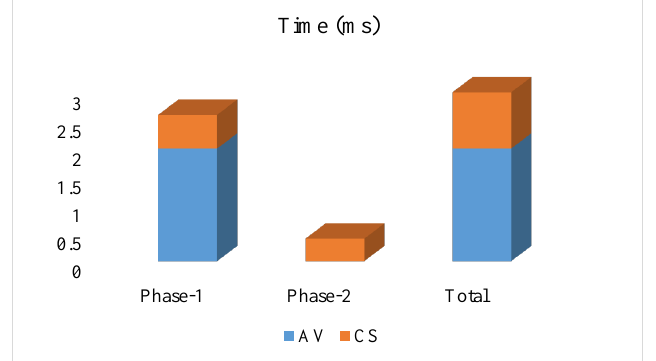
Figure 14. Computational time of different phases of